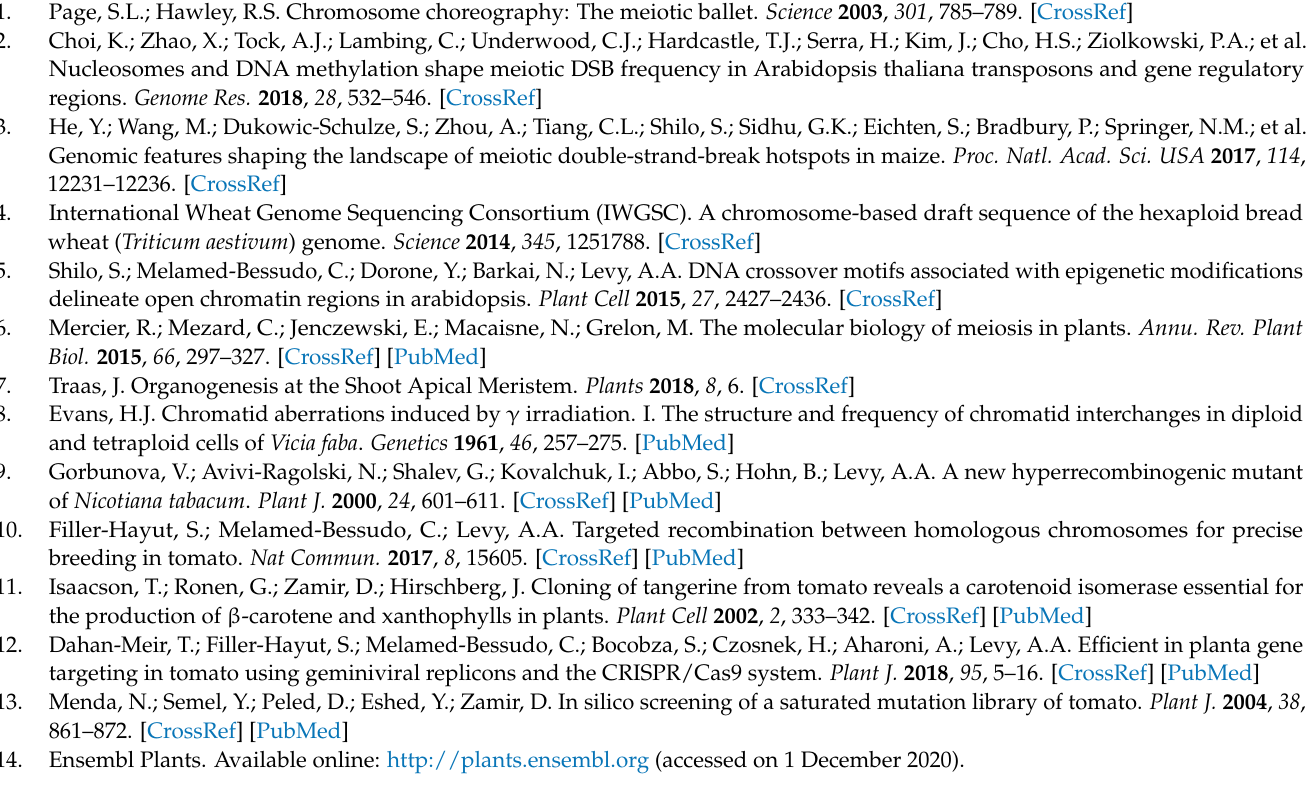
DSB IHSR assay, Supplementary Table S7. CRTISO targeted DSB IHSR phenotypic assay targets comparison, Supplementary Figure S1. NHEJ frequency in F 1 plants of CRTISO assay DSB targets, Supplementary Figure S2. Sequencing of IHSR events in the CRTISO 8–9 region around the targeted DSB in plant#1, Supplementary Figure S3. Sequencing of IHSR events in the CRTISO 8–9 region around the targeted DSB in